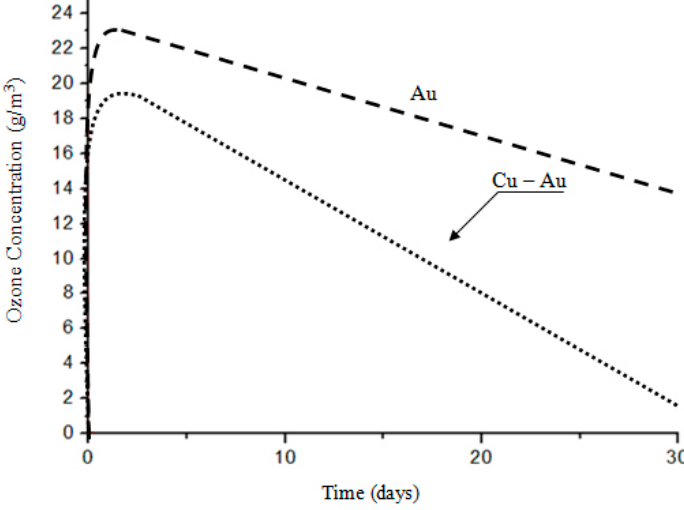
Figure 2. Photograph of electrodes after monthly use in a plasma reactor: ( a ) gold electrode, ( b ) copper electrode galvanized with gold and matte after use.